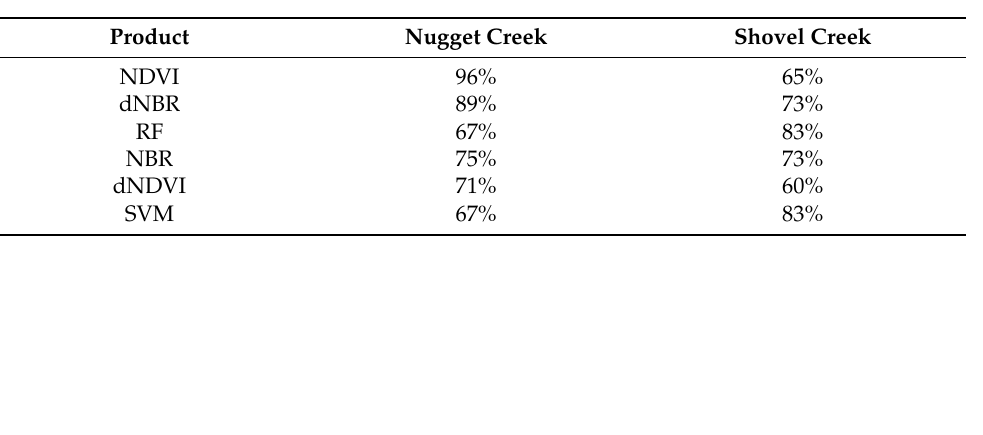
Figure 4. Correlation between CBI values and indices with Pearson correlation coefficients for the Nugget Creek fire plots. Table 3. Accuracy table of the burn severity map products for the Nugget Creek and Shovel Creek